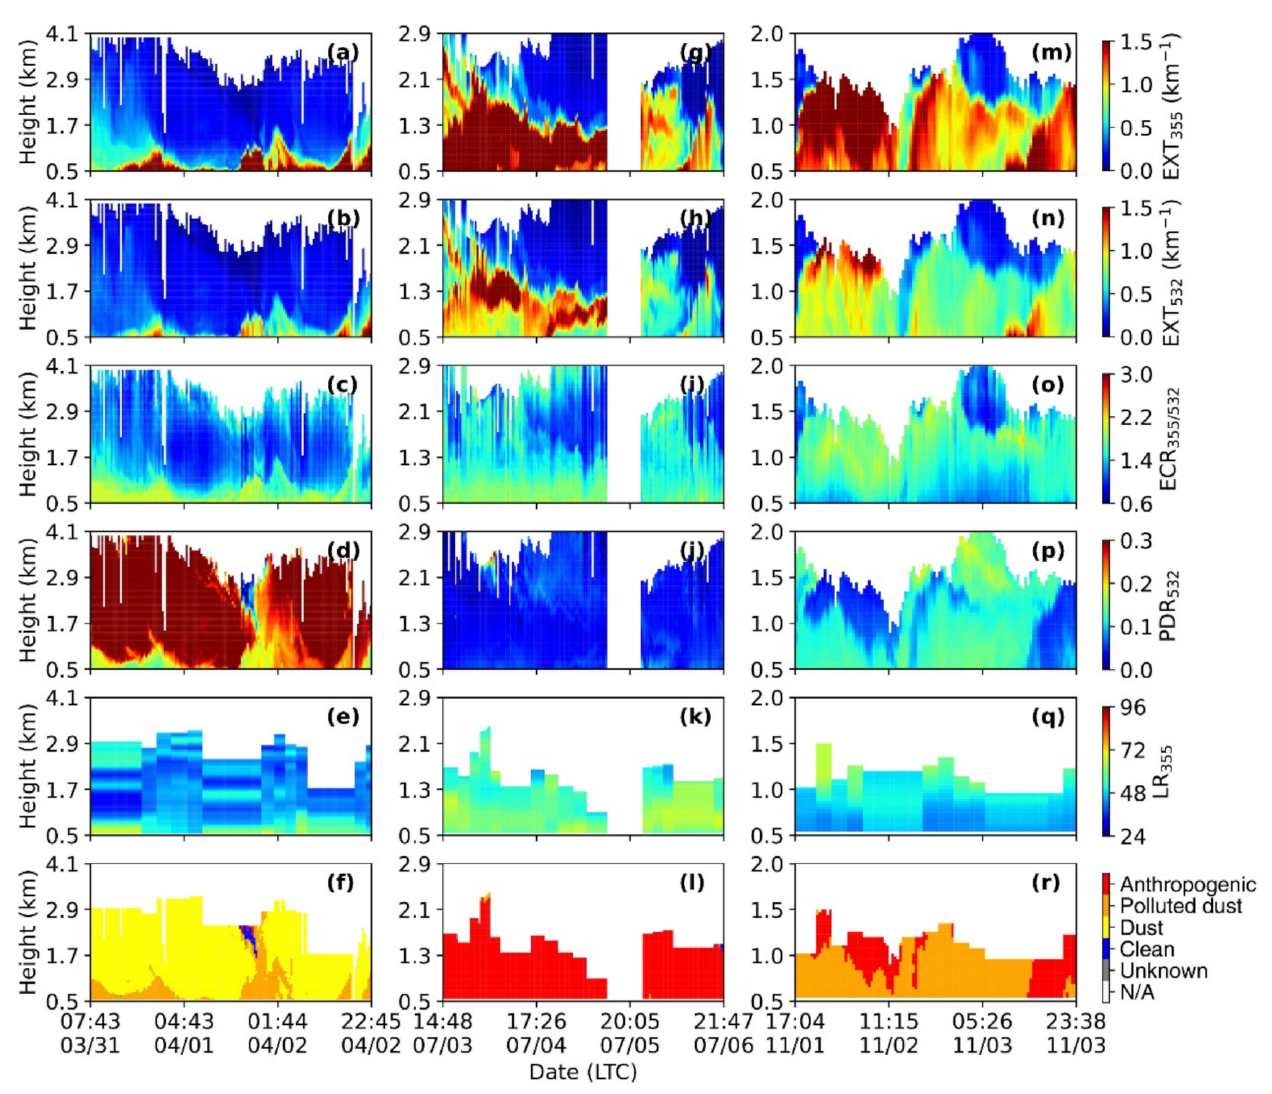
Figure 3. Time–height plots of the extinction coefficient at 355 nm (EXT 355 ), EXT 532 , extinction color ratio (ECR 355/532 ), particle linear depolarization ratio (PDR 532 ), lidar ratio (LR 355 ), and classification results from ( a – f ) 7:43 on 31 March to 22:45 on 2 April, ( g – l ) 14:48 on 3 July to 21:47 on 6 July, and ( m – r ) 17:04 on 1 November to 23:38 on 3